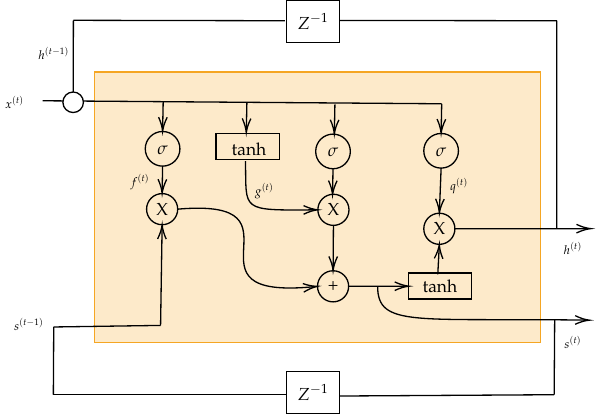
Figure 1. Block diagram of one cell of a long short term memory